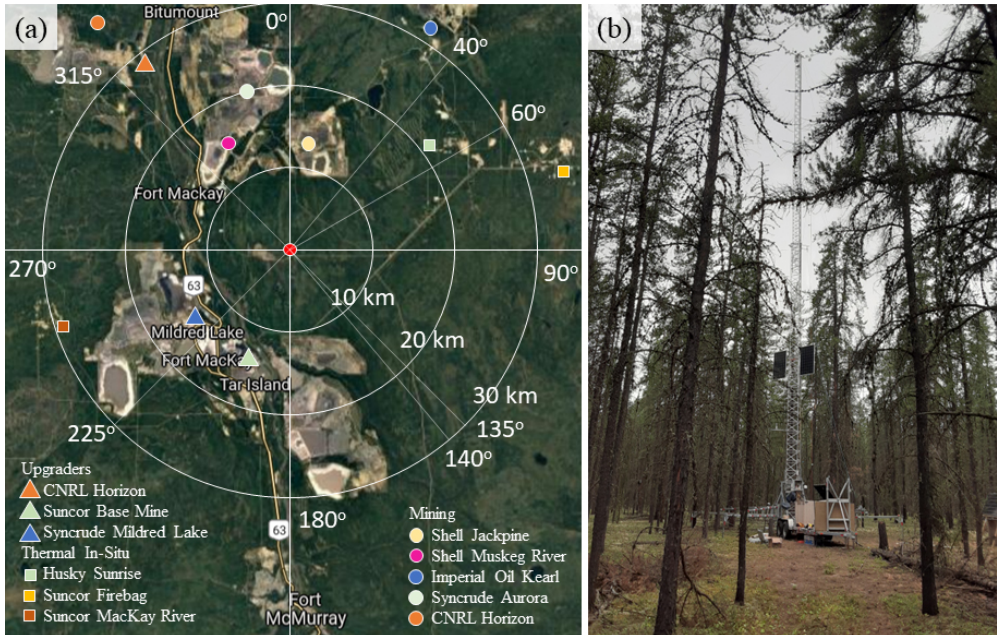
Figure 1. (a) YAJP tower site location (red circle) and surrounding area with 10, 20, and 30km radius circles. Radial directions shown (0, 40, 60, 135, 140, 225, and 315 ◦ ) are used to group observations by source. Image is © Google Maps (2020) with upgrader and mine locations added from Davidson and Spink (2018). (b) The tower and the surrounding jack pine